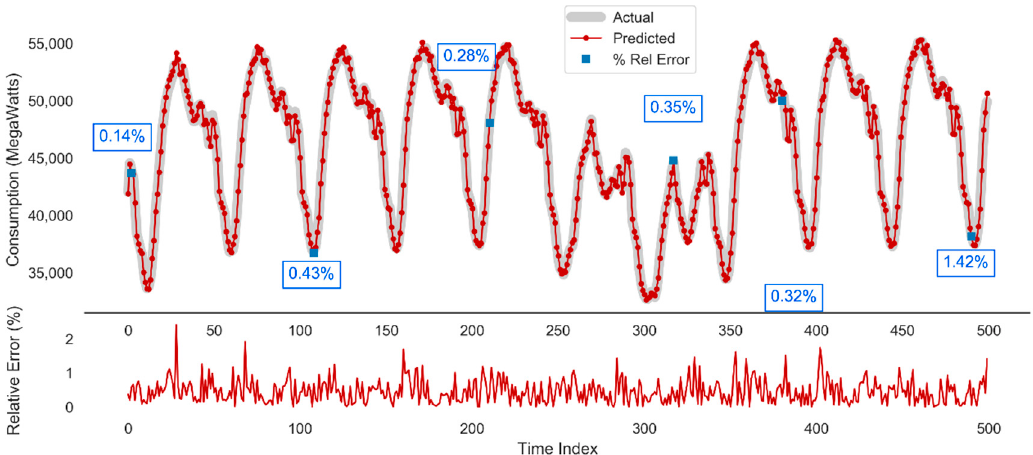
Figure 15 . Actual vs. predicted forecast achieved by the multi-sequence LSTM model and relative error variation.